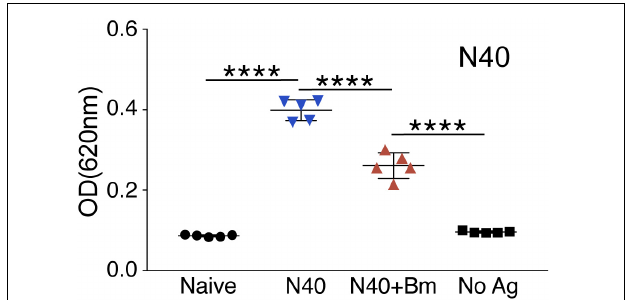
FIGURE 7 | Determination of the specific antibody response in N40 infected and co-infected mice at day 21 p.i. ELISA analysis using N40 protein extract probed with pooled plasma of either N40 infected or co-infected mice indicated a significant reduction ( ∗∗∗∗ p < 0.0001, df = 8, F = 1.55) in the specific antibodies against B. burgdorferi in co-infected mice. No reactivity was observed in the negative control (No Ag) or using naïve mice